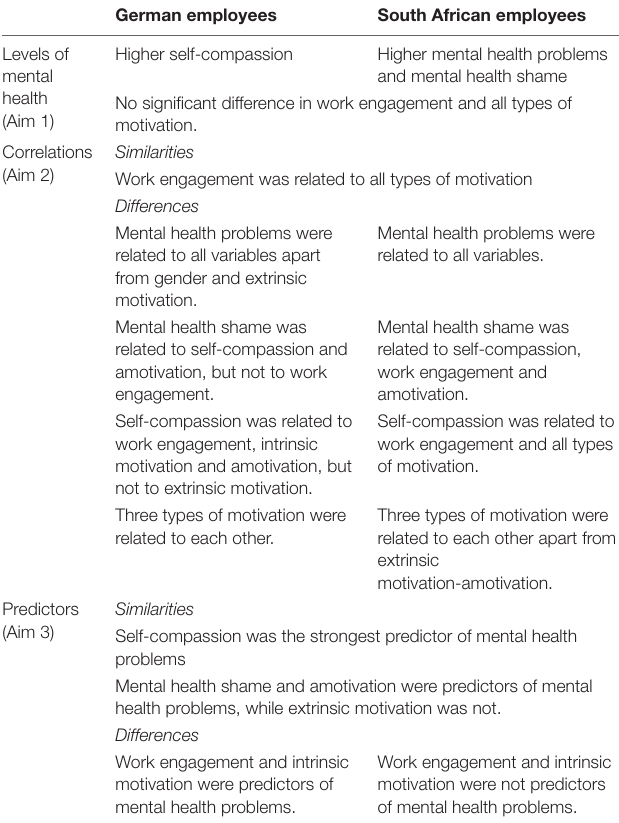
TABLE 4 | Summary of the findings, comparing mental health of German and South African employees. German employees South African